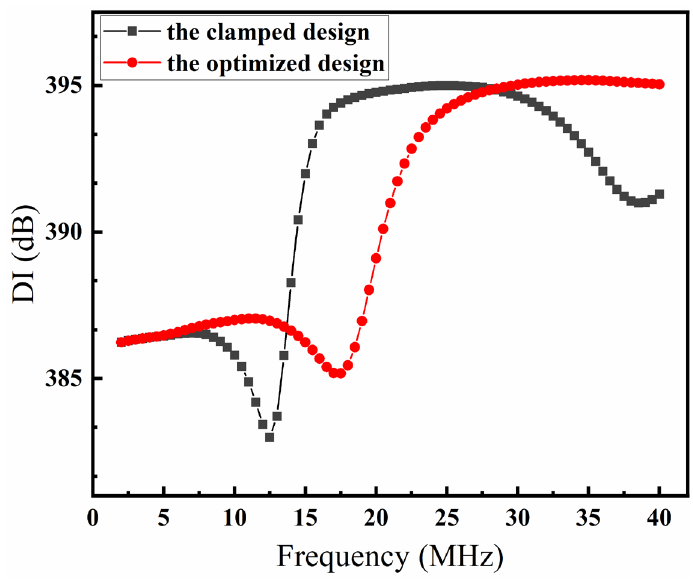
Figure 9. The size of the directivity index of the two structures.